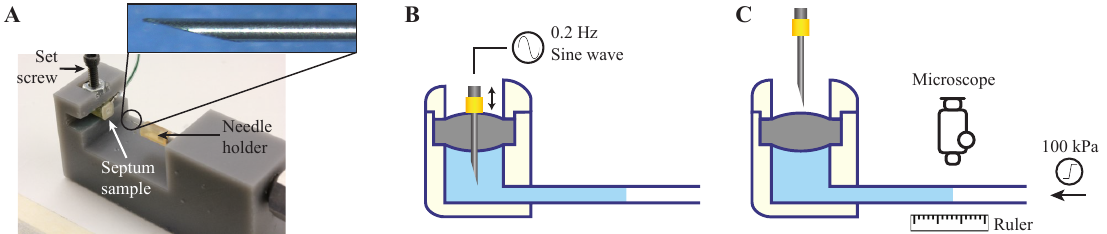
Figure 3. Benchtop test setup for septum characterization. ( A ) A puncture device was made to hold septum samples in a groove with a set screw and punctures were made with a needle through the septum with an automated pneumatic mechanism. Inset: a 30 Ga non-coring 12 ◦ beveled needle used for puncture test. ( B ) The septa test samples were punctured in a single point with the puncture device fed by a 0.2 Hz sine wave signal. ( C ) After a set number of punctures, the pneumatic system was stopped, and backpressure was gradually increased to 100 kPa. At the same time, the fluid front displacement was quantified by a microscope with a resolution of 2.4 nL /